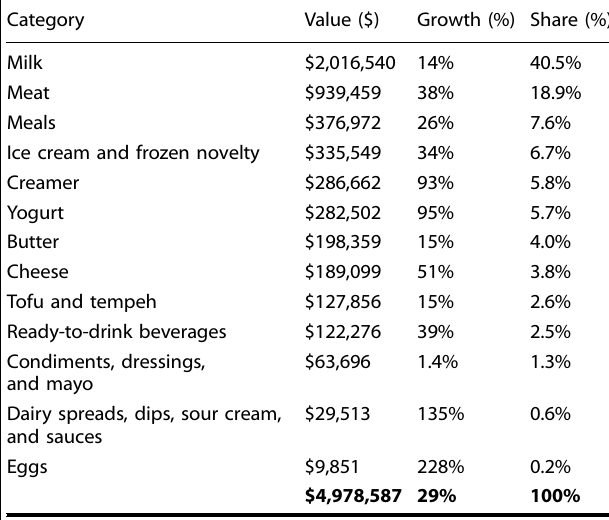
Table 1. Market value of plant-based food products in the United States (2019), growth over a two-year period (2017 – 2019), and market share (2019).